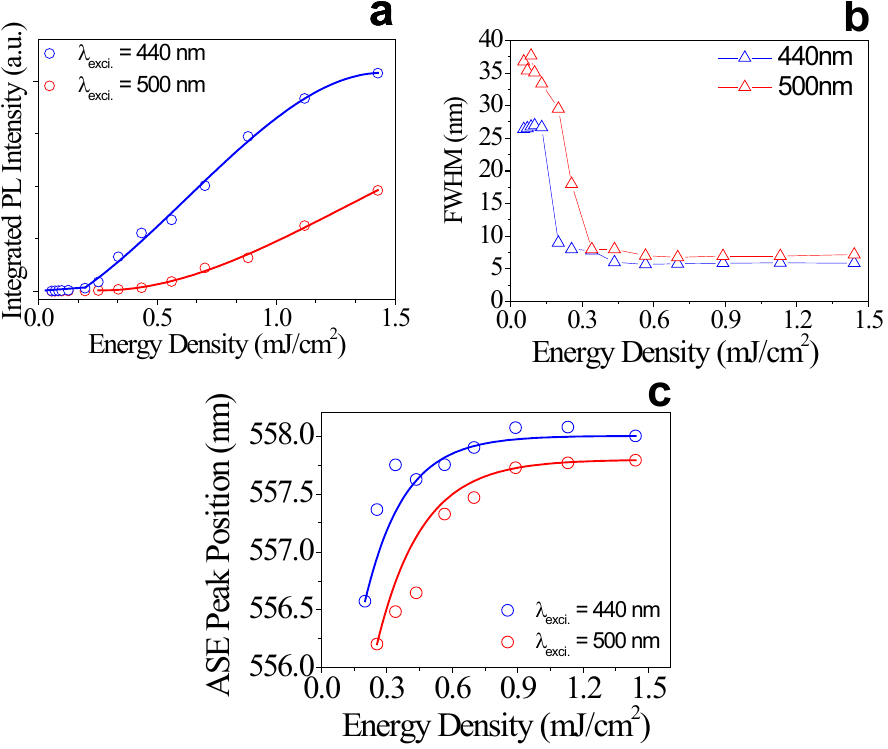
Figure 3. Integrated PL intensity ( a ), FWHM ( b ), and ASE peak position ( c ) vs. the pulse energy density under both excitation wavelengths.